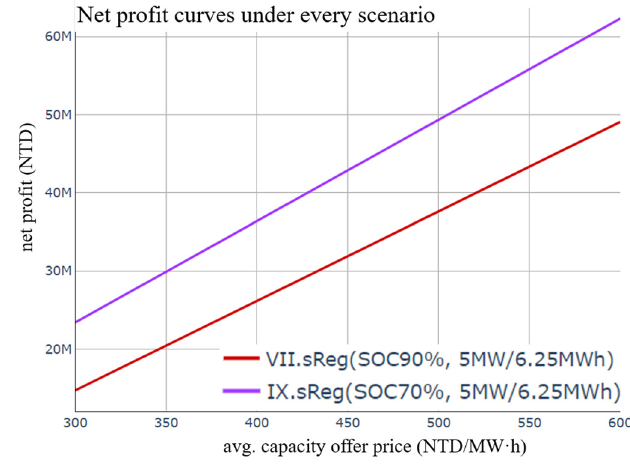
Figure 26. Net profit under different SOC levels (sReg).